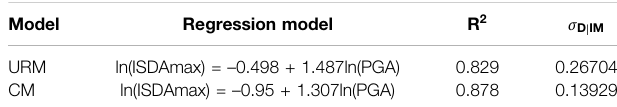
TABLE 4 | Parameters for the probabilistic demand models of URM and CM subjected to mainshock only.